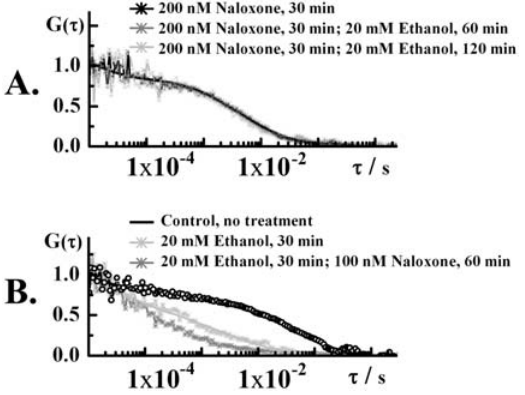
(data not shown), whereas the effect of ethanol on plasma membrane lipids appeared to be enforced through MOP. In control cells, regular PC12 cells that express very low if any MOP, the direct effect of ethanol on the lipid dynamics was very slow and moderate changes could be observed only after prolonged, several